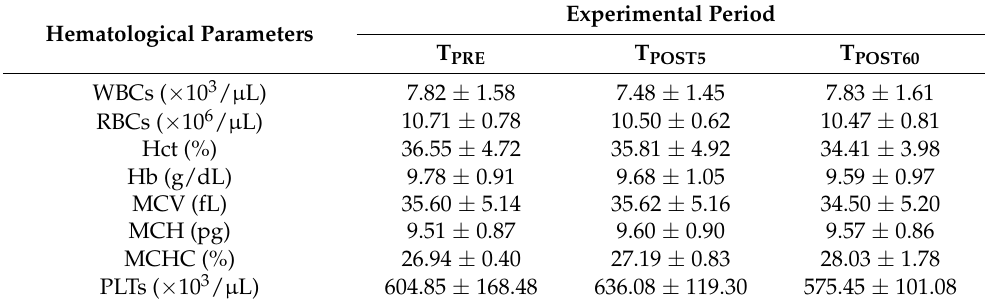
Table 1. White blood cells (WBCs), red blood cells (RBCs), hematocrit (Hct), hemoglobin (Hb), mean corpuscular volume (MCV), mean corpuscular hemoglobin (MCH), mean corpuscular hemoglobin concentration (MCHC) and platelets (PLTs) measured in ewes before shearing (T PRE ) and after 5 and 60 min (T POST5 and T POST60 ) from the end of shearing. Data are expressed as mean values ± standard deviation (SD).